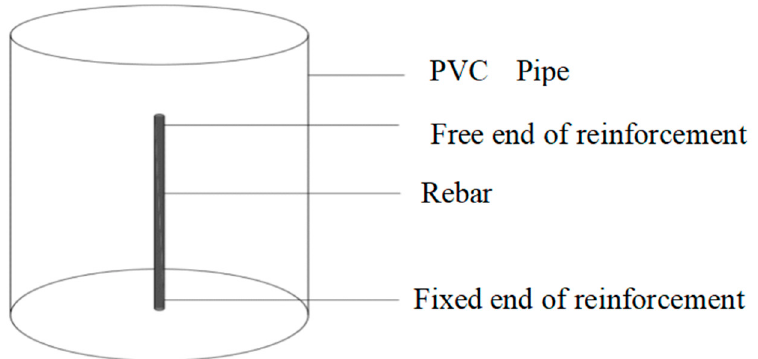
Figure 4. Schematic of the reinforced concrete samples (PVC = polyvinyl chloride).